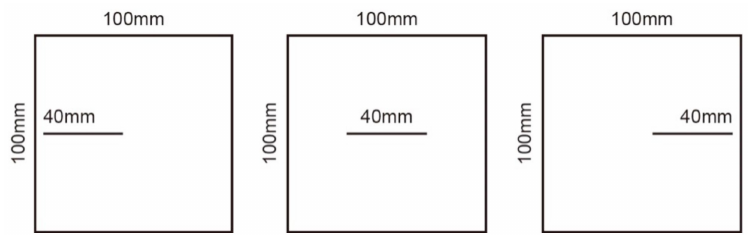
Figure 4. Schematic diagram of joint specimens in scheme III.